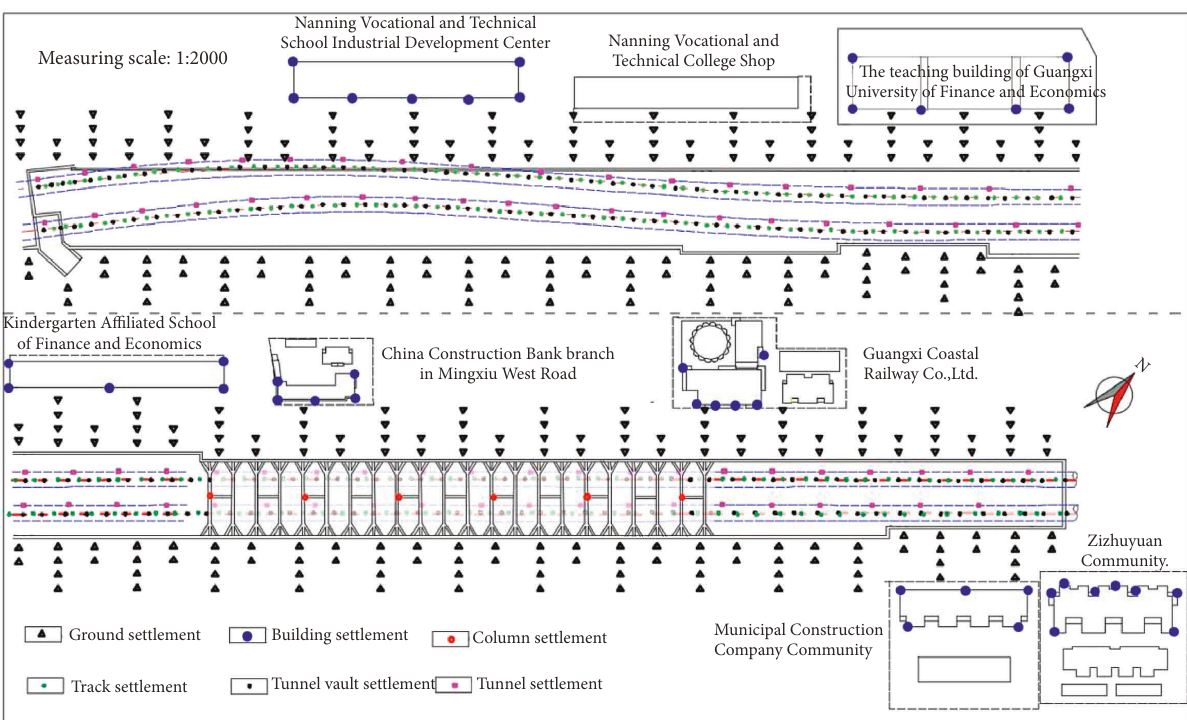
Figure 5: Layout of monitoring points.